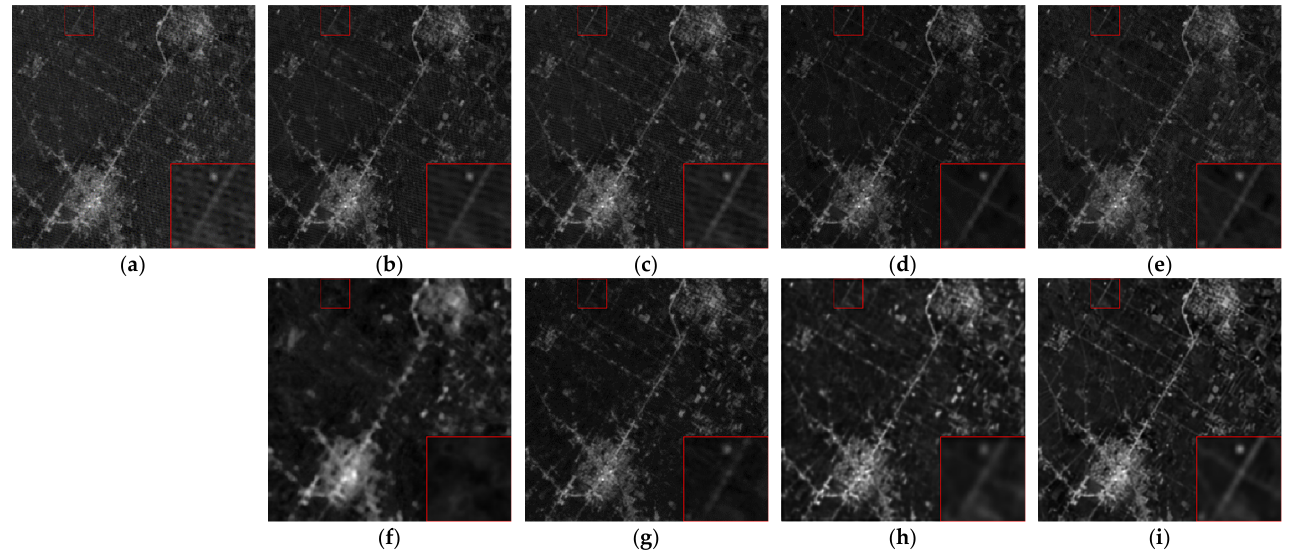
Figure 17. PRISMA hyperspectral image denoising results with band 66: ( a ) real image; ( b ) BM4D;